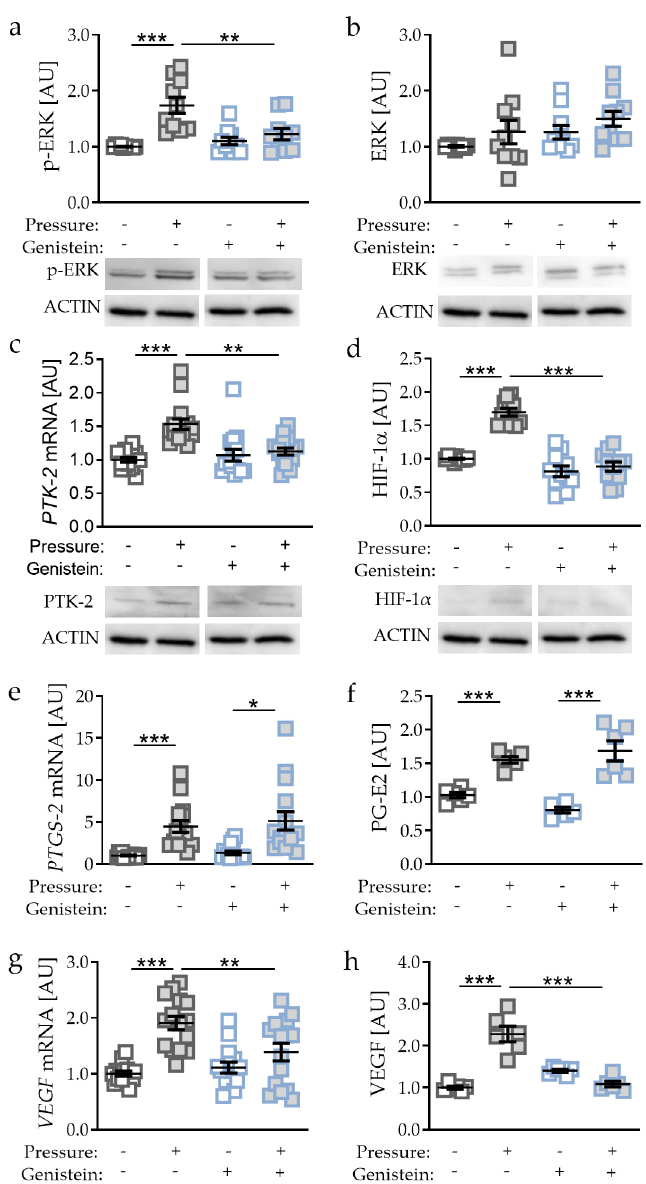
Figure 5. E ff ects of compressive strain with and without PTK-2 inhibitor genistein on p-ERK ( a ), ERK ( b ), PTK-2 ( c ), HIF-1 α ( d ), PTGS-2 / PG-E2 expression ( e , f ), and VEGF expression ( g , h ). Protein expression: n = 6; gene expression: n = 15. Statistics: ordinary one-way ANOVA followed by Holm–Sidak’s multiple comparison tests or Welch-corrected ANOVA followed by Games–Howell multiple comparison tests; AU = arbitrary units; * p < 0.05, ** p < 0.001, *** p <